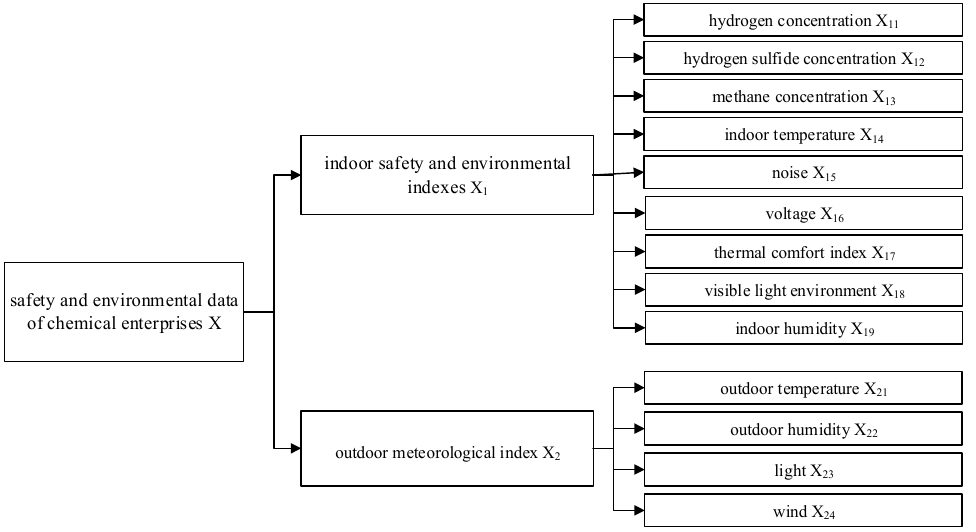
Figure 1. SEDCI index screening and hierarchical division.